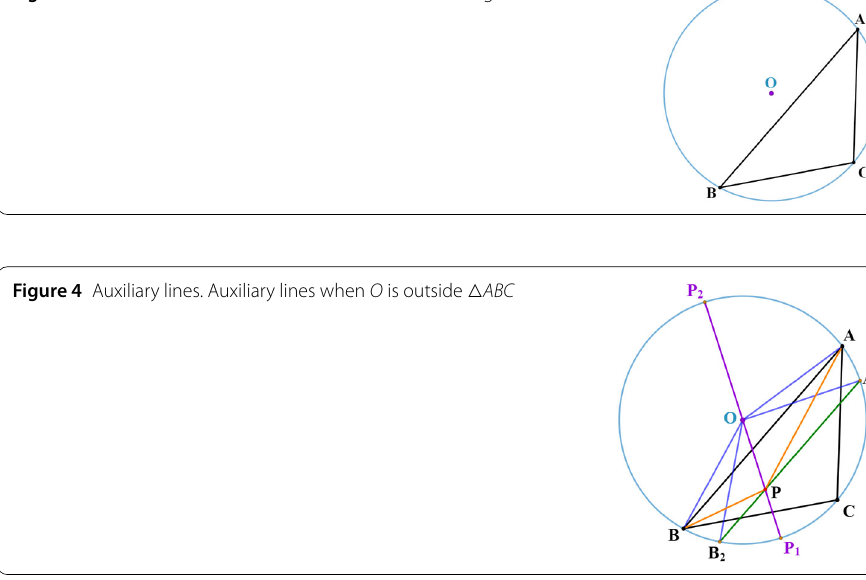
Figure 3 O is outside. The circumcenter is outside the triangle